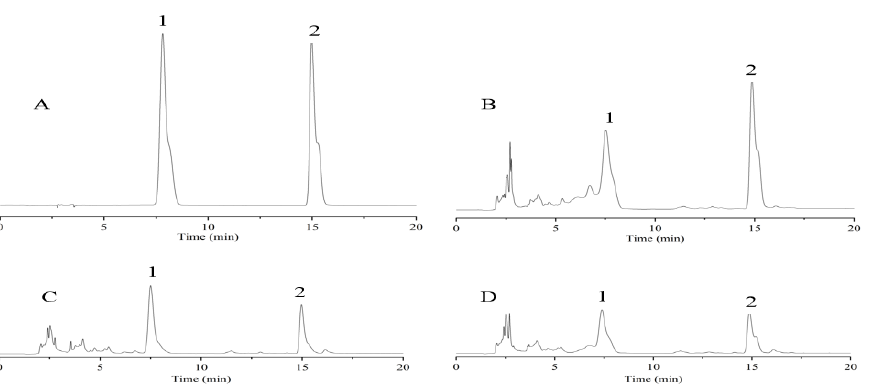
Figure 8. HPLC chromatograms of RVT and RAS. ( A ) Standards; ( B ) RAS; ( C ) RVT-1; ( D ) RVT-2; 1, chlorogenic acid; 2, ferulic acid.